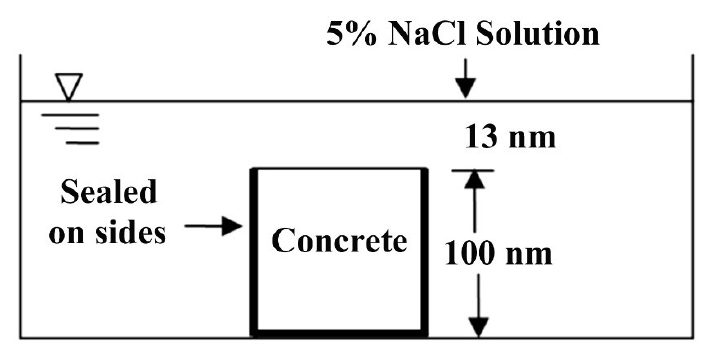
Figure 1. Sketch of the immersion